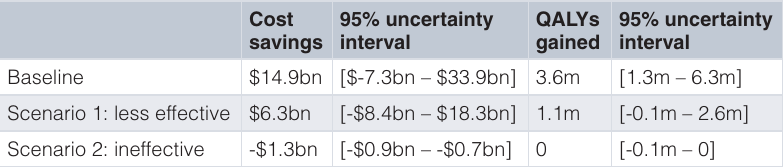
Table 2. Scenario analyses for adoption compared to baseline adoption